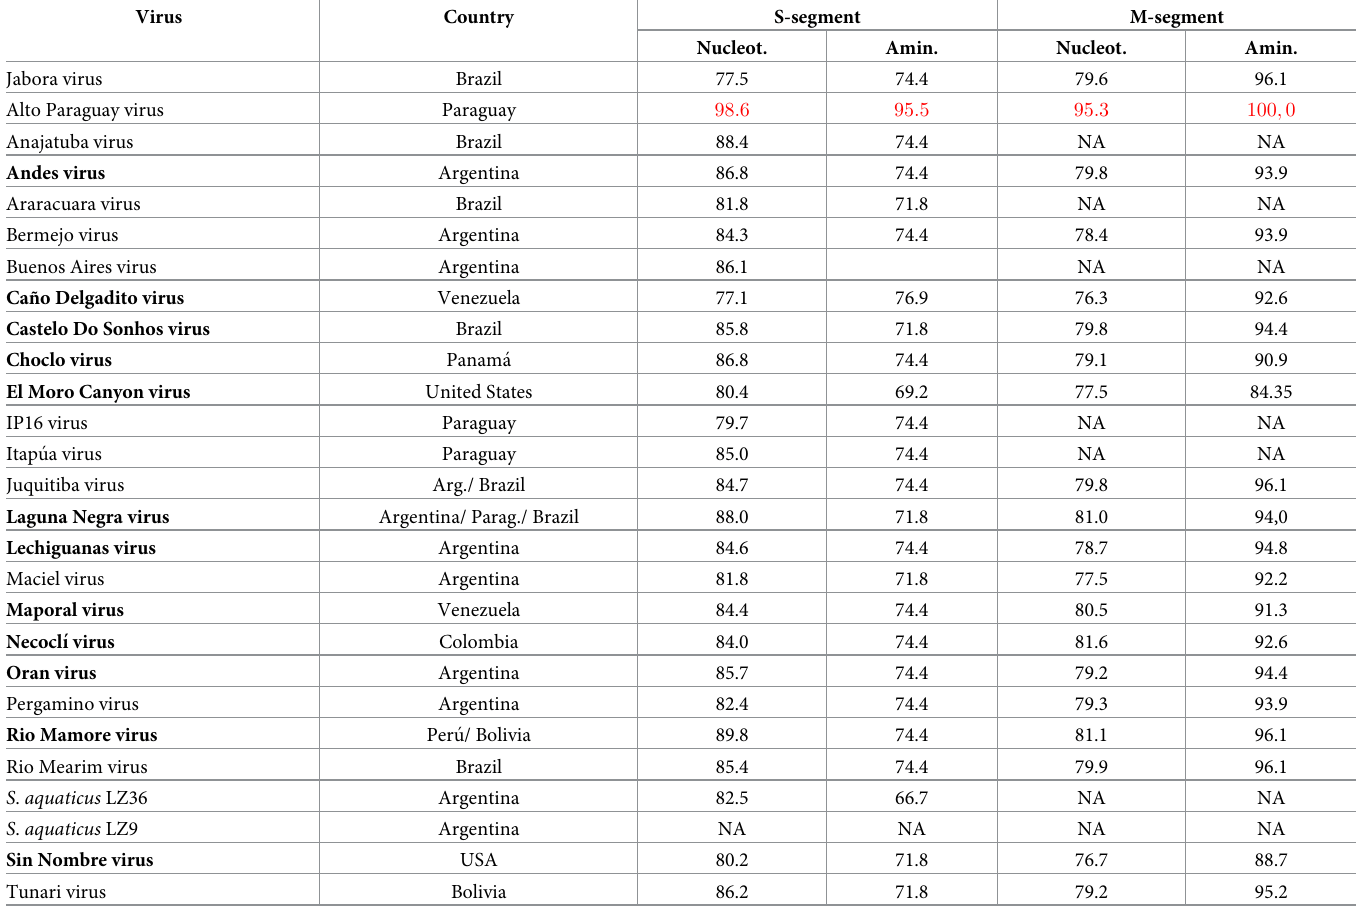
Table 2. Pairwise nucleotide and amino acid identity percentages between virus sequences amplified from Hantavirus Pulmonary Syndrome case, Santa Fe prov- ince, Argentina and selected American orthohantaviruses.